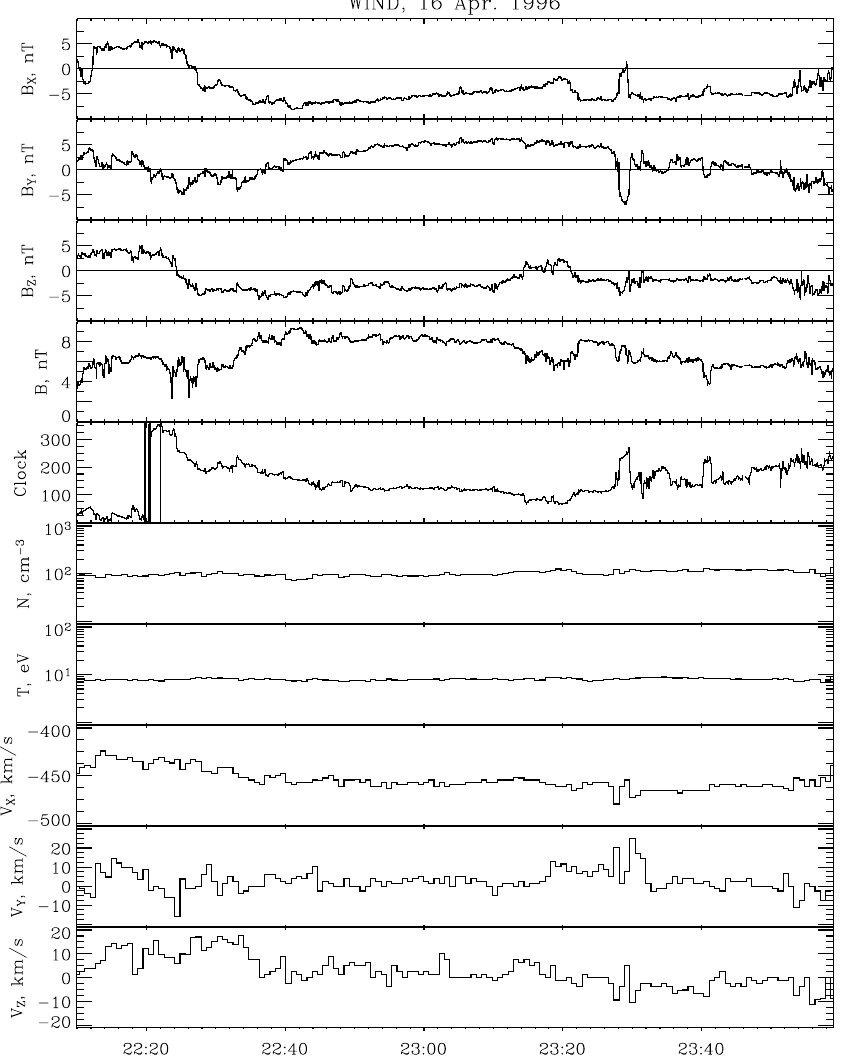
Fig. 13. WIND magnetic field and plasma data for Interball observations of LLBL on 16 April 1996. Format of this figure is the same as